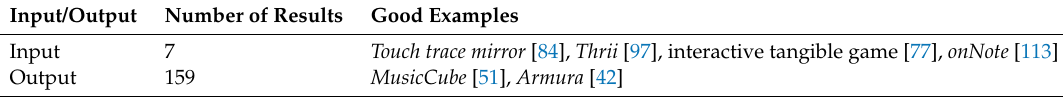
Table 8. Classification and examples of light as input/output in the review results.